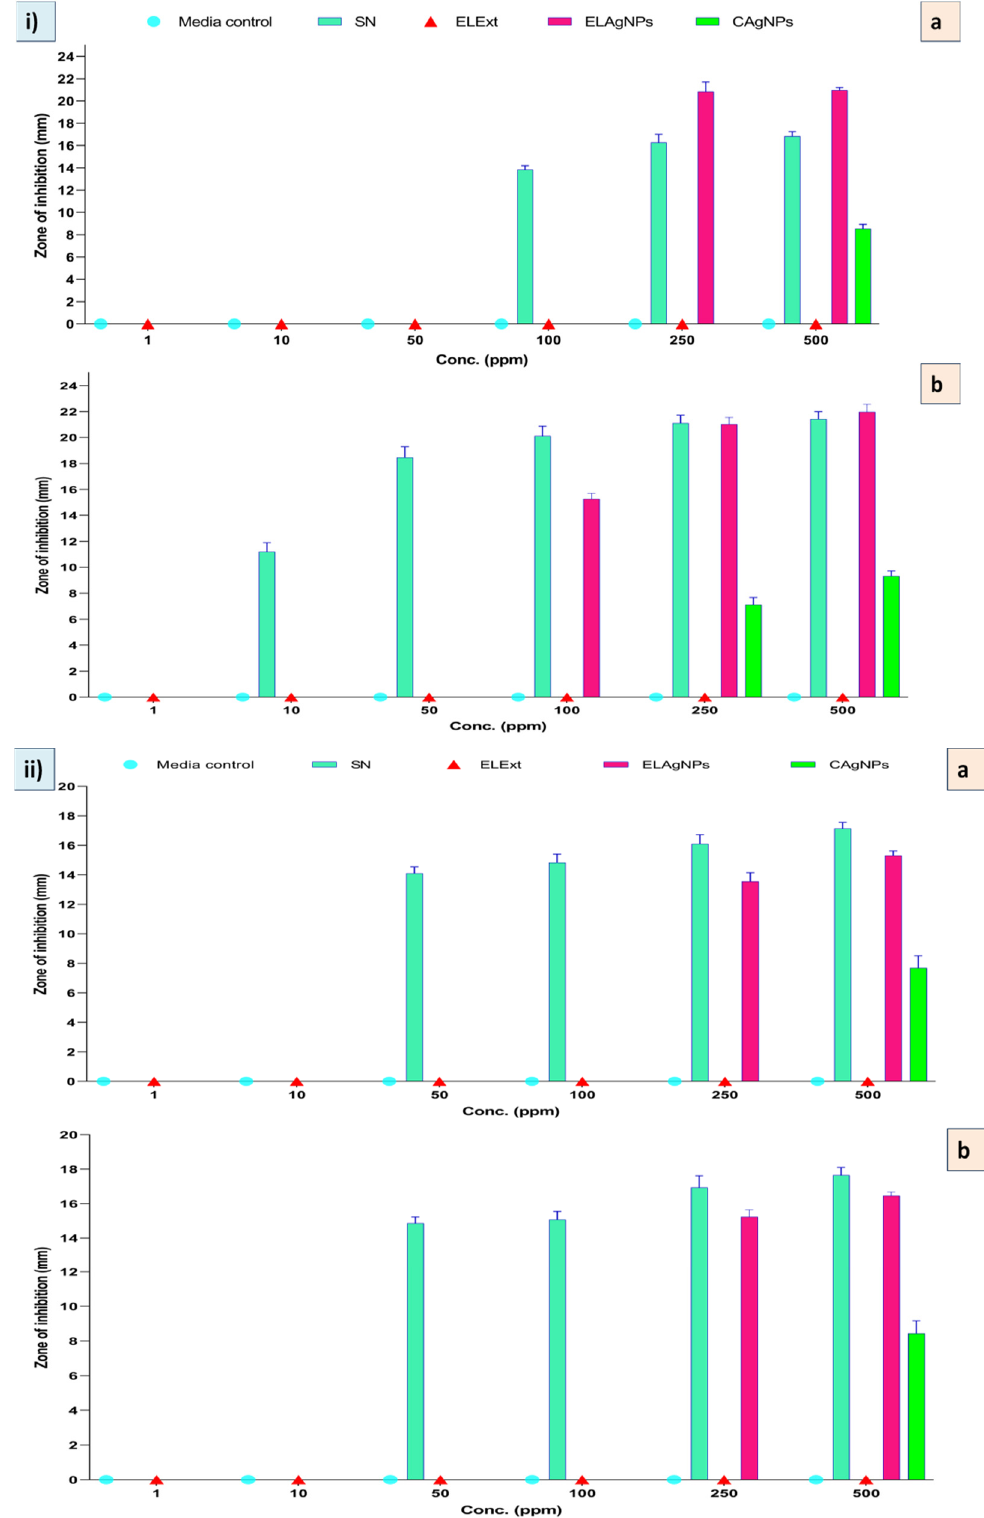
Figure 6. Antibacterial activity of green synthesized ELAgNPs against ( i ) B. subtilis and ( ii ) E. coli after (a) 12 h and (b) 24 h of incubation (data are presented as mean ± SD of four replicates).